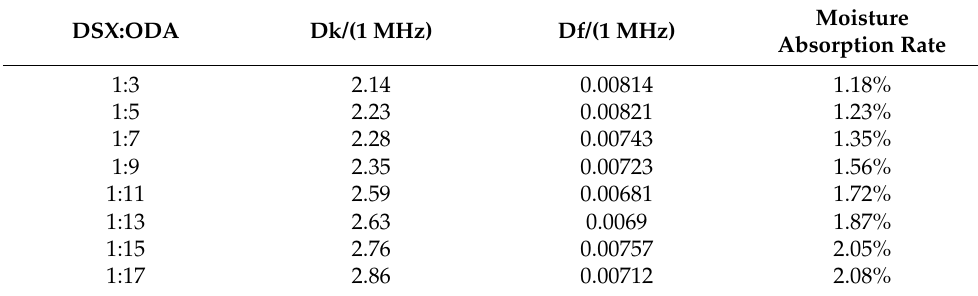
Table 6. At 1 MHz, the Dk and dielectric loss (Df) of 1 PI film in each proportion.